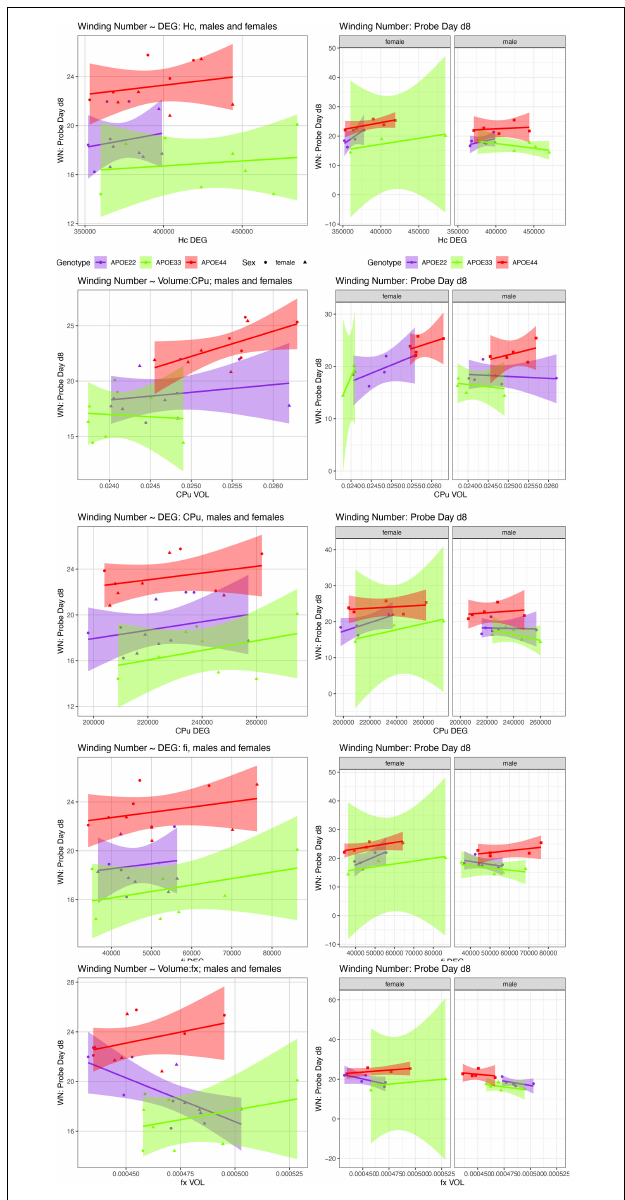
FIGURE 8 | The day 8 AWN ∼ MRI metrics models. APOE3 mice showed differences between males and females in the slopes for the hippocampus degree of connectivity, caudate putamen volume, and degree of connectivity, while males and female APOE2 mice were different for the fimbria degree of connectivity. The fornix volume showed differences between females APOE2 and APOE3 ( p = 0.04), and APOE2 vs. APOE4 differences were characterized by p = 0.06. Shaded areas indicate 95% confidence